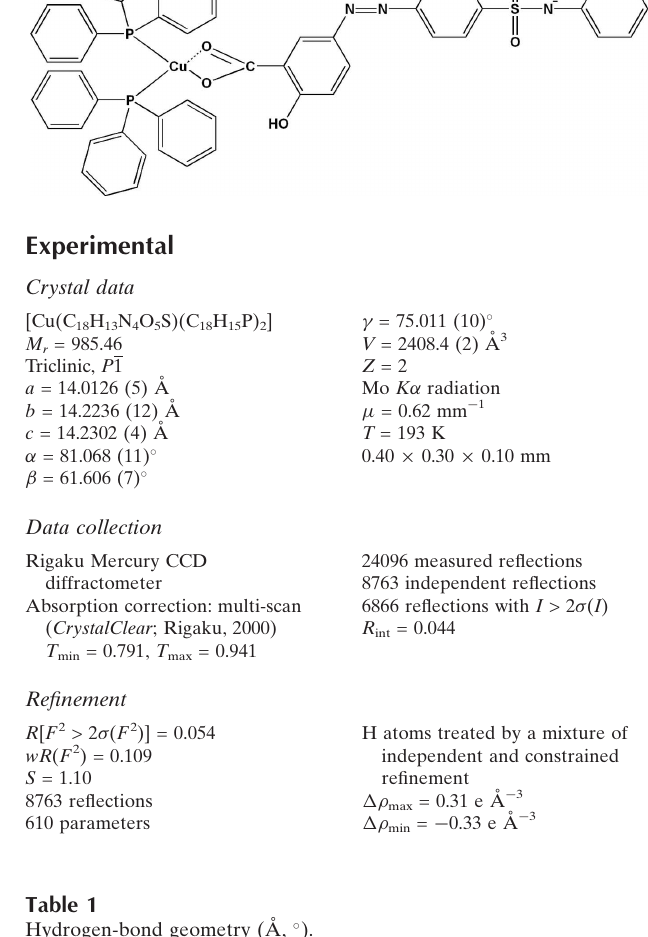
Hydrogen-bond geometry (A˚ , (cid:3) ).